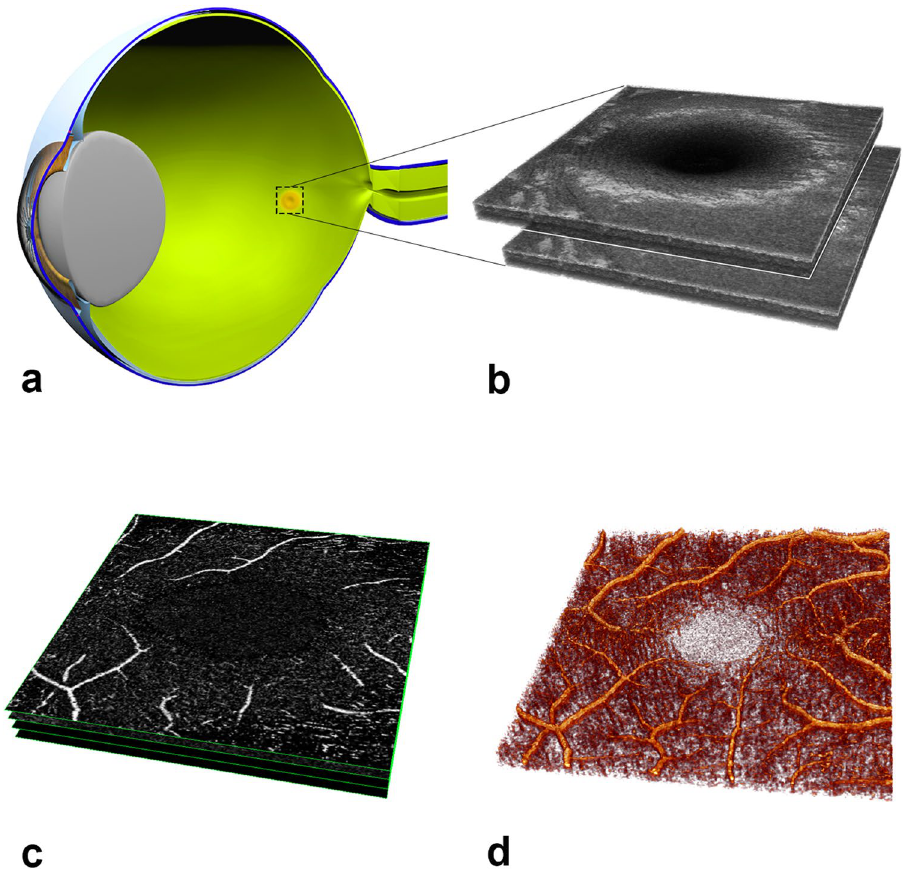
Figure 2. Presentation of image processing in three-dimensional optical coherence tomography angiography. ( a ) Schematic representation of an eye that has been cut open in order to provide a better explanation. In the posterior region, a brownish area is depicted, which corresponds to the location of the sharpest vision, the macula. Cross-sectional images of the macula in the area of the rectangle were captured from the same location. ( b ) These images correspond to structural OCT data that can be rendered into a volume representation. By repeatedly applying the same volume (here, two such volumes are shown as an example), the change in the OCT signal compared to the static tissue signal, which does not change much, can be interpreted as representing the blood flow. ( c ) Based on this, a common representation of the blood flow within the vessels can be shown via an en face image display method. Four such cross-sectional en face images are depicted here (each highlighted in green). However, as a trade-off between the amount of data and the processing, the intervening vessel parts are lost. ( d ) A three-dimensional rendering of the same data, showing the entire course of the vessels and their interrelationship. The rounded and vascular-free area in the center corresponds to the foveolar avascular zone (FAZ), in which the photoreceptors can interact as directly as possible with